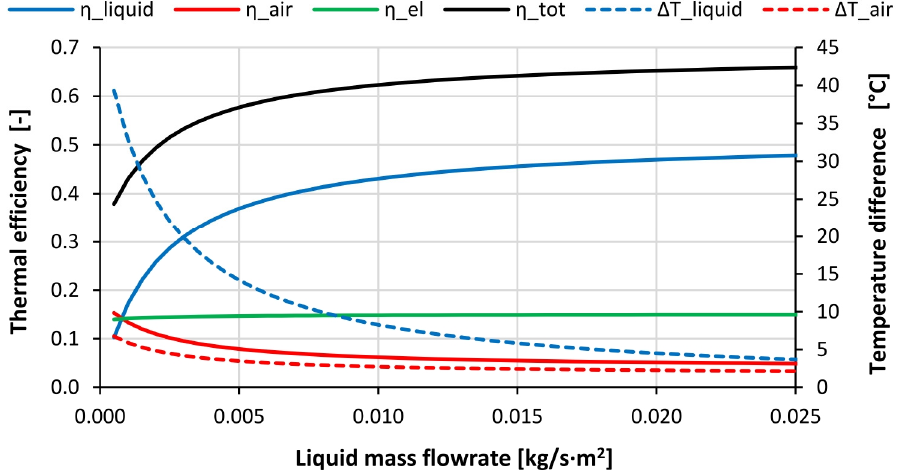
Figure 4. Performances of the bi-fluid PV/T versus the liquid flow rates. The variation of the liquid flow rates, starting from stagnation conditions to 0.010